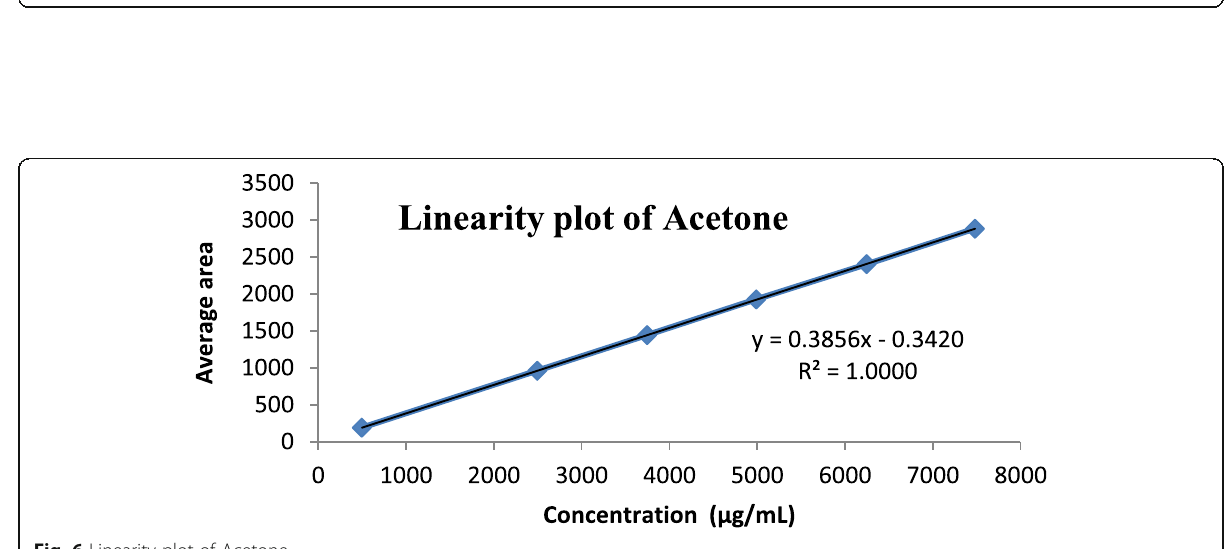
Fig. 6 Linearity plot of